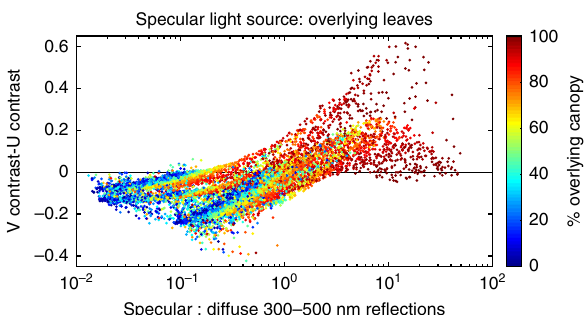
Fig. 8 The ratio of specular to diffuse re fl ections from leaves affects optimal spectral tuning for perceiving leaf-contrast. The optical model revealed that optimal spectral sensitivity for visualizing leaf-contrast depends not only on the specular light source (see Fig. 7a), but also on the ratio of specular to diffuse re fl ections radiating from the upper leaf surface. This ratio depends on how much of the sky is blocked by overlying canopy. The less light that makes its way through holes in the overlying canopy, the greater the proportion of specular re fl ections relative to diffuse re fl ections, and the more bene fi cial the V-cone for visualizing leaf-contrast. The line at y = 0 indicates the point at which both UV-cone variants see equal